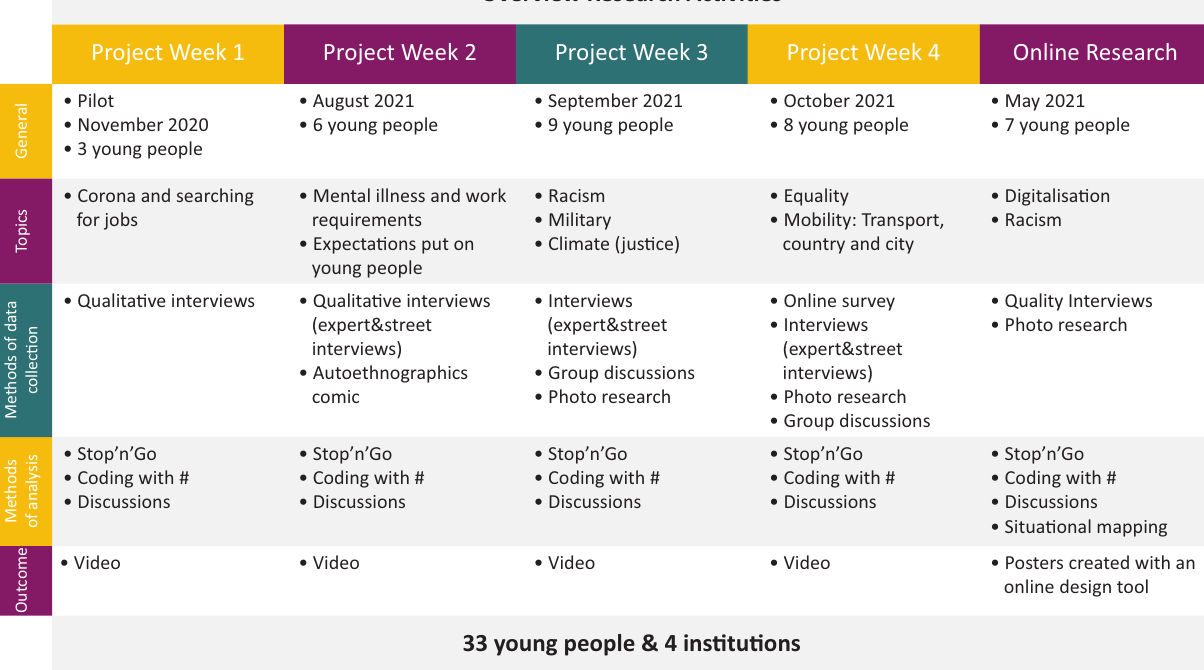
Figure 1. Overview of participatory research